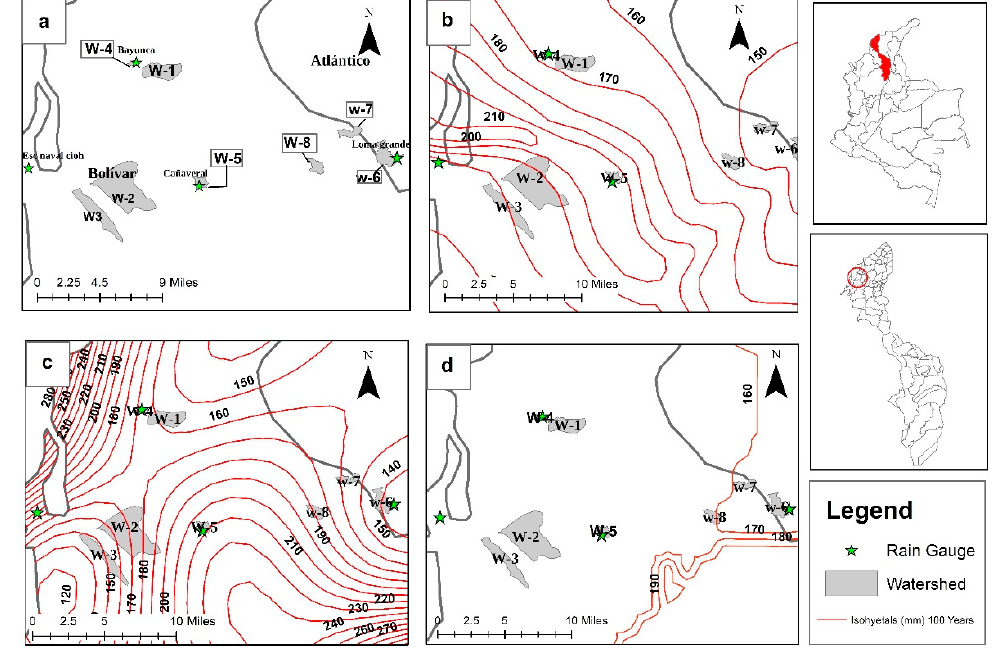
Figure 5. ( a ) Location of the watersheds and rain gauges; ( b ) areal precipitation of isohyetals by IDW adjusted; ( c ) areal precipitation by the spline method; ( d ) areal precipitation of isohyetals by the OK OK method.